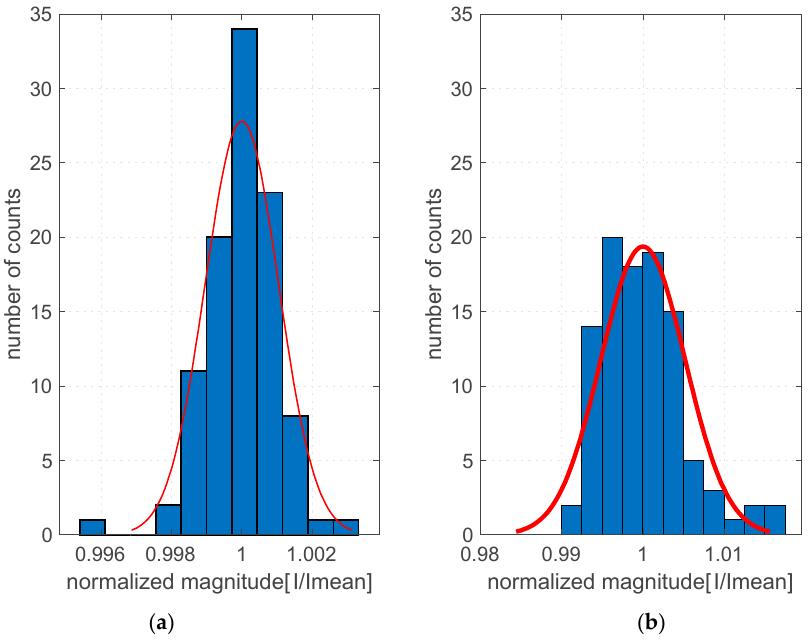
Figure 5. Statistical distribution of measurement results as a measure of repeatability of presented measurement methods. ( a ) Two-microphone probe and ( b ) one-microphone probe.